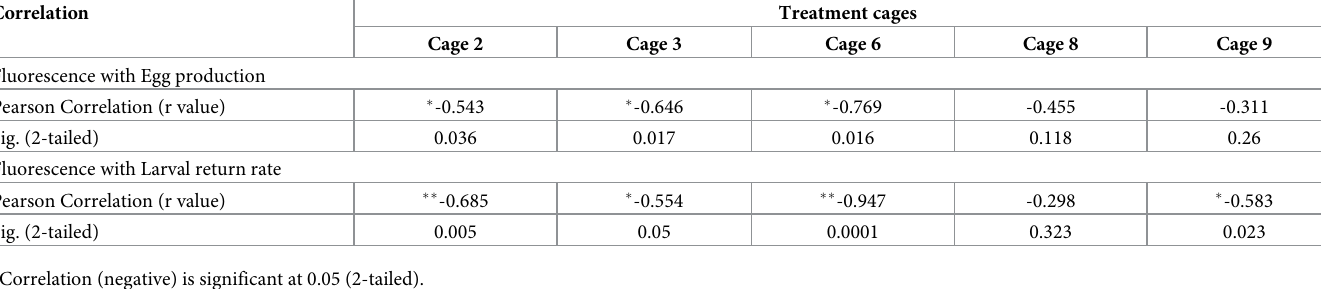
Table 2. Correlation between fluorescence with egg production and fluorescence with larval return rate post initiation of OX513A male adult introduction in treat- ment cages from week 15.